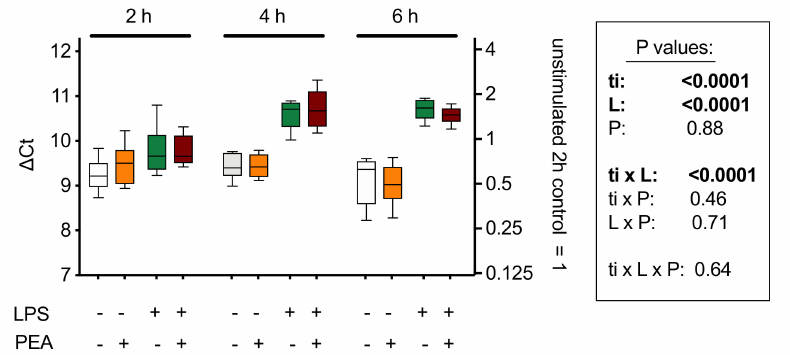
Figure 6. mRNA levels of Napepld , coding for NAPE-hydrolysing phospholipase D (NAPE-PLD) in J774 cells cultured in 24-well plates for 24 h and treated for 2, 4, and 6 h with lipopolysaccharide (LPS, 0.1 µ g / mL) + interferon- γ (100 U / mL) and / or 10 µ M PEA. Shown are box and whisker plots, N = 8. The mRNA values are determined using Rpl19 as reference gene and are given as ∆ Ct with the mean values relative to the unstimulated controls at the 2 h time point on the right y -axis. A decrease of 1 ∆ Ct unit represents a doubling in the mRNA concentration. The box shows the results of a 3-way ANOVA (ti, time; L, LPS + interferon- γ ; P, PEA. These indicate a time-dependent e ff ect of the inflammatory stimulus on Napepld expression, but no significant e ff ect of PEA treatment. Figure redrawn from